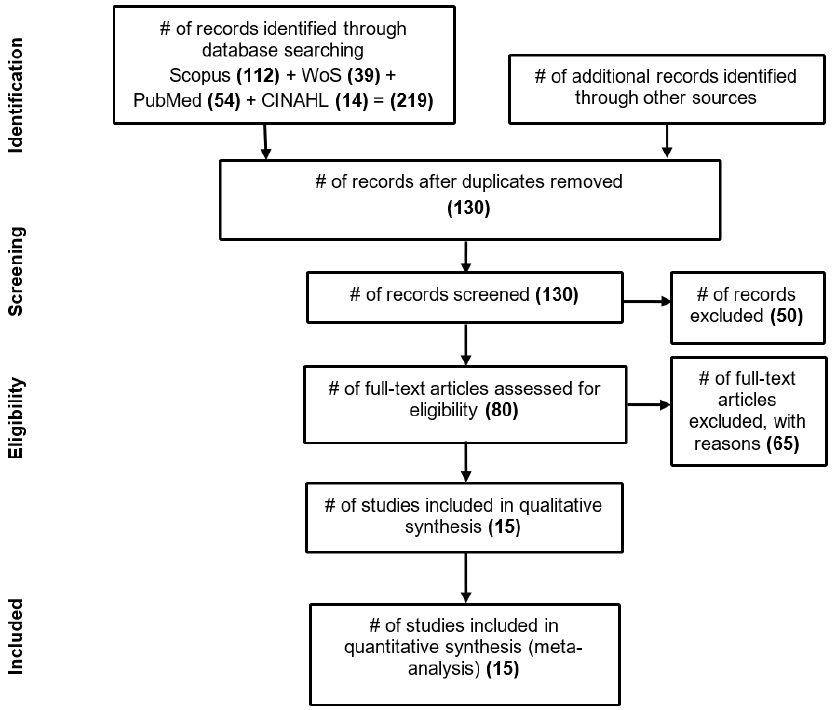
Figure 1. Information flow through the different phases of a systematic review (adapted from the PRISMA Statement [25] (p.5)). Table 1. Justifications for excluding the full